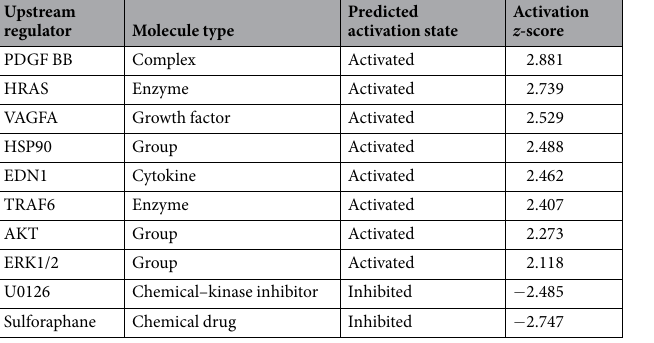
Table 1. Prediction of activated/inhibited signalling in HUVECs treated with exosomes released from PK-45H cells.